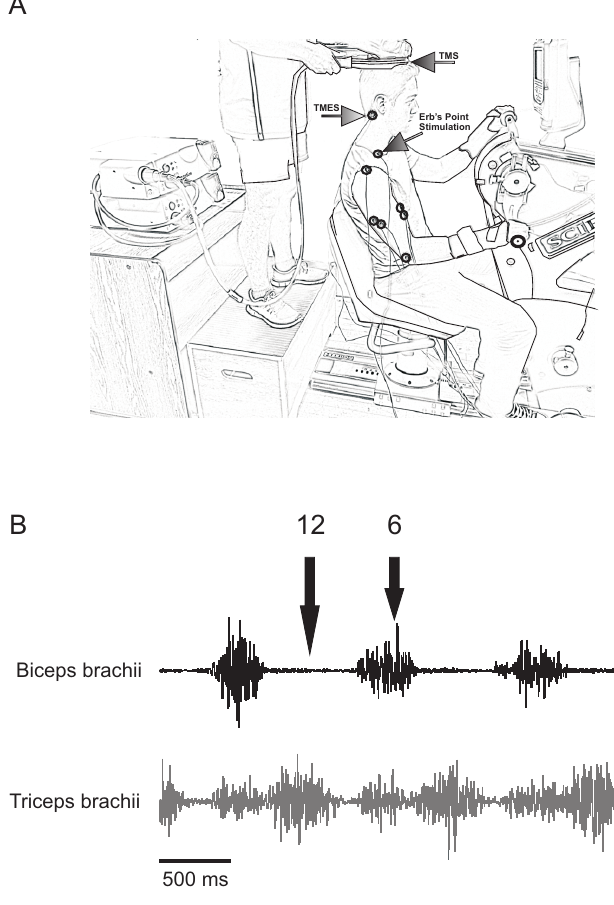
Figure 1. Experimental set-up. ( A ) Participants were seated with their shoulders at approximately the same height as the axis of the crank shaft on the cycle ergometer while cycling at 60 rpm at two different workloads (5% and 15% of peak power output (PPO)). Measurements were taken at the 6 o’clock (shown here) and 12 o’clock positions from the dominant arm; ( B ) Raw electromyography (EMG) trace for the biceps and triceps brachii from one participant. Note the monophasic and biphasic activation patterns of the biceps and triceps brachii, respectively. Black arrows labelled 12 and 6 represent the positions according to the face of a clock where stimulations were elicited (no stimulations in the traces shown). Abbreviations are: TMS, transcranial magnetic stimulation; TMES, transmastoid electrical